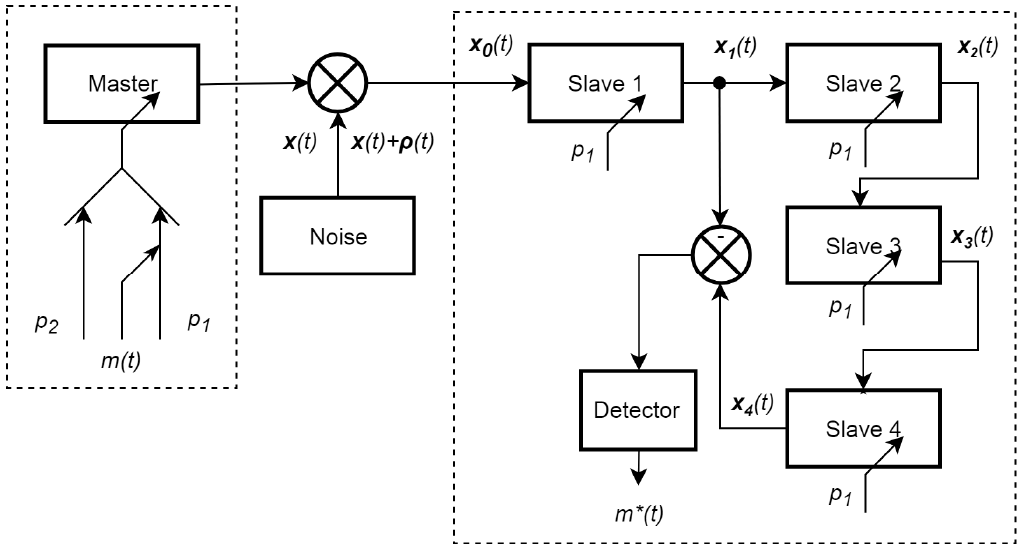
Figure 9. The chain of driven oscillators involving 4 oscillators.